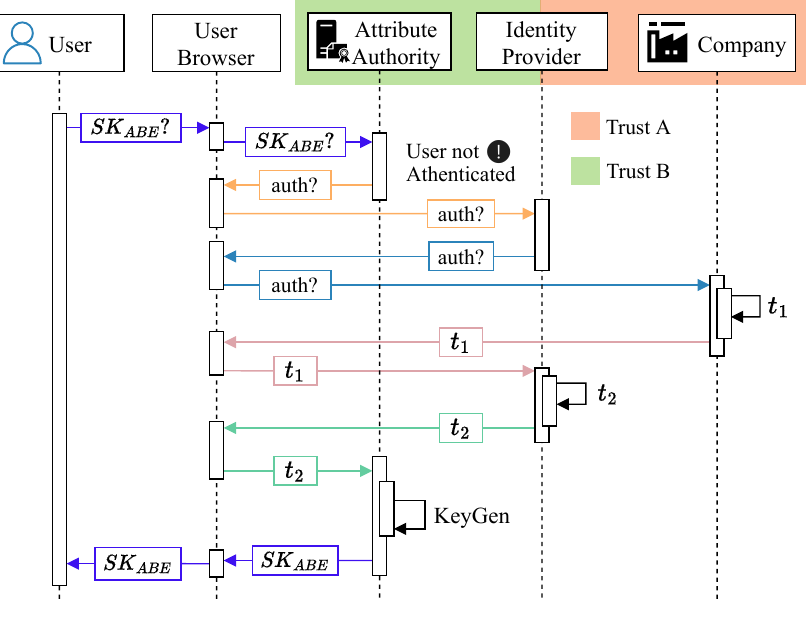
Figure 4. FIM message